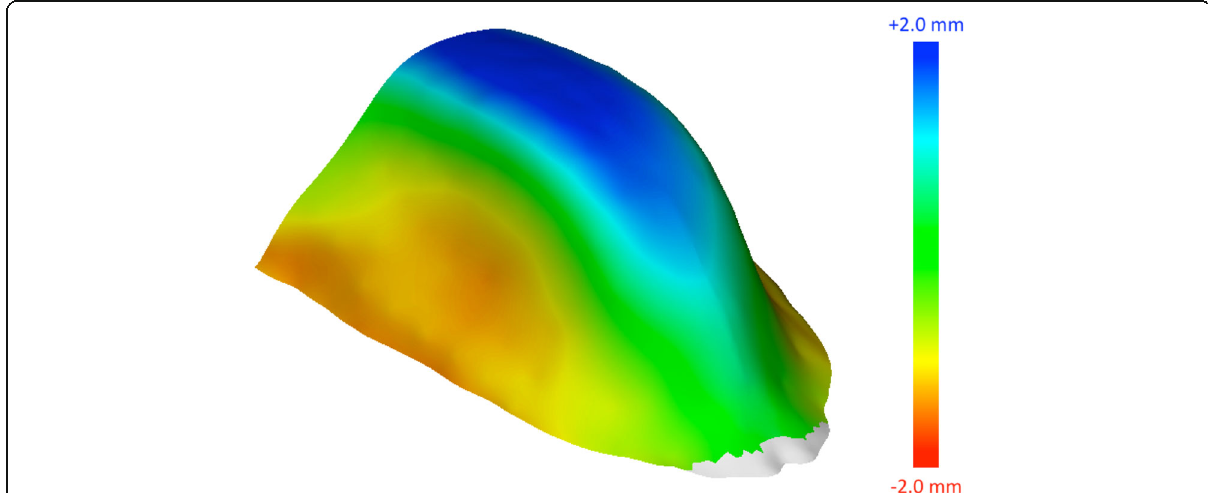
Fig. 4 Colorimetric maps showing the differences in shape after superimposition between the average palate of mouth breathers and nasal breathers: the palate is narrower and higher in mouth breathers